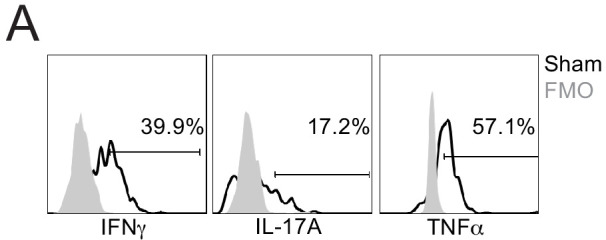
FMO controls for direct ex vivo cytokine staining.(A) Representative flow plots of direct ex vivo IFNγ, IL-17A, and TNFα producing cells, gated on MOG-specific CD4 T cells, from sham (black) mice. Gray profiles indicate ‘fluorescence minus one’ (FMO) controls for each respective cytokine. Numbers indicate frequency of cytokine-positive cells for sham cells.